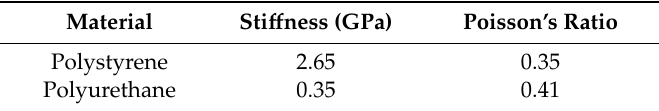
Table 1. Material mechanical